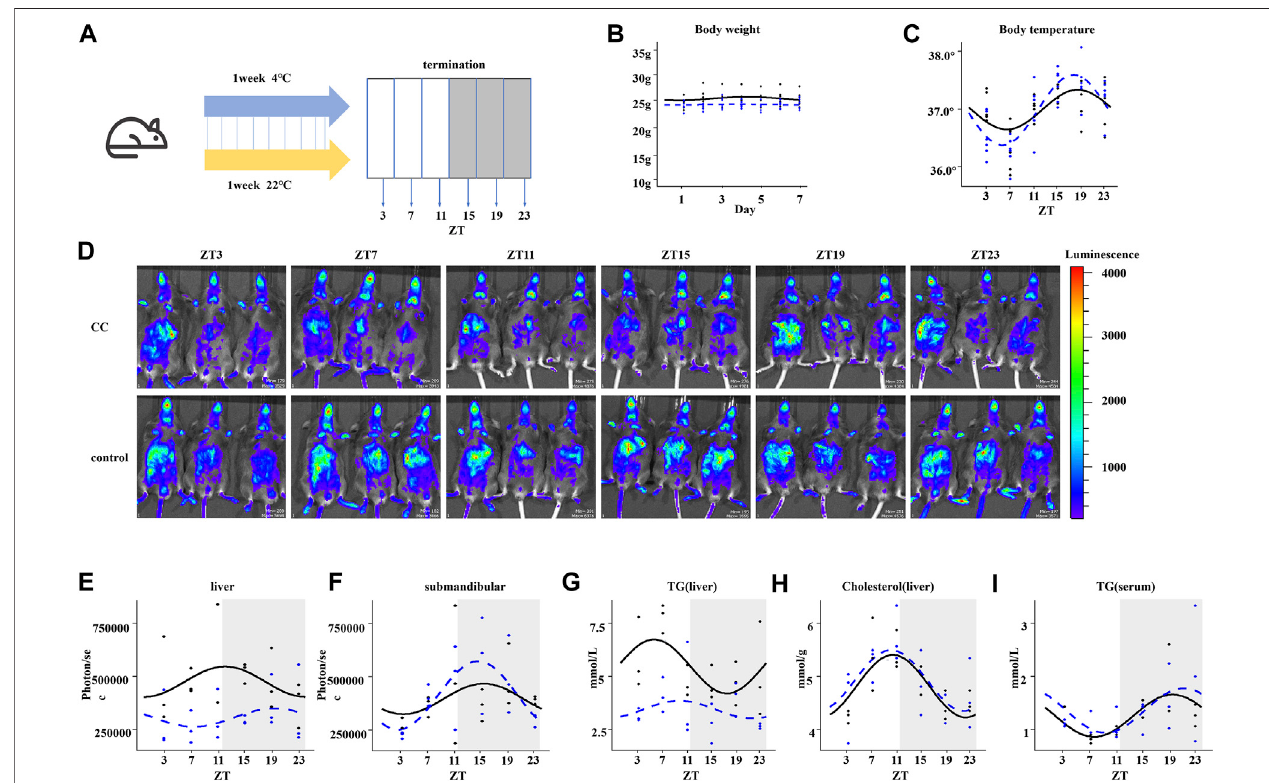
FIGURE1| Chroniccoldaltersthecircadianrhythmsandmetabolisminmouseliver. (A) Work fl owofthechroniccoldexposureexperimentinmice.After1 weekof WT mice housed at 22 ° C or 4 ° C, the corresponding indexes were measured, or tissues and organs were collected at 4-h intervals within 24 h. (B) Body weight of WT mice. (C) Body temperature of WT mice. The black line indicates the control group, and the blue dotted line indicates the chronic cold (CC) group; points are individual data points, and lines represent cosinor regression fi t; the body temperature rhythm between control and CC groups was compared; the amplitude was signi fi cantly different; the p -value was 0.028 ( < 0.05). (D) Fluorescent images of PER2: LUC mice. At each time point, three PER2: LUC mice were detected simultaneously. The fl uorescence of the liver and submandibular gland eight min after injection of fl uorescein is shown . (E) Quanti fi cation of the liver bioluminescence data in (D) , in photons per second, showed a signi fi cant difference in MESOR between CC and control groups. p -value was 0.0004 (less than 0.05), and there was no statistical signi fi cance in other rhythm characteristics. (F) Quanti fi cation of the submandibular gland bioluminescence data in (D) , in photons per second. (G) Circadian liver triglyceride content from WT mice between the control and CC groups; the MESOR was signi fi cantly different; the p -value was 0.00005 ( < 0.05). (H) Circadian liver cholesterol. (I) Circadianserumcholesterol.Theblacklineindicatesthecontrolgroup,andthebluedottedlineindicatesthechroniccold(CC)group.Pointsareindividual data points, and lines represent cosinor regression fi